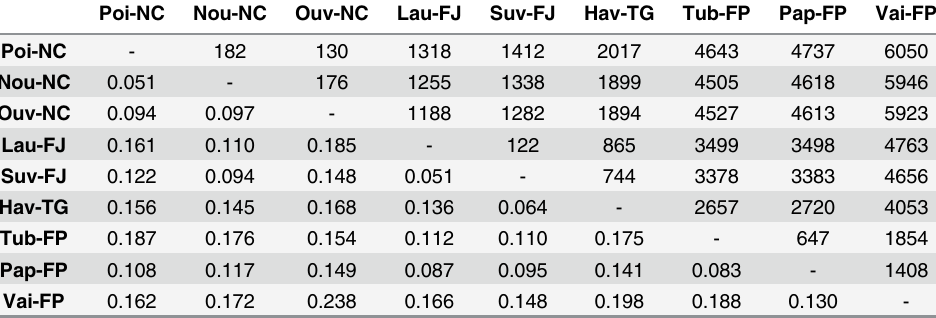
Below diagonal, F ST values, statistical signi fi cance was 0.05. Above diagonal, geographical distances (km) between the sample sites.